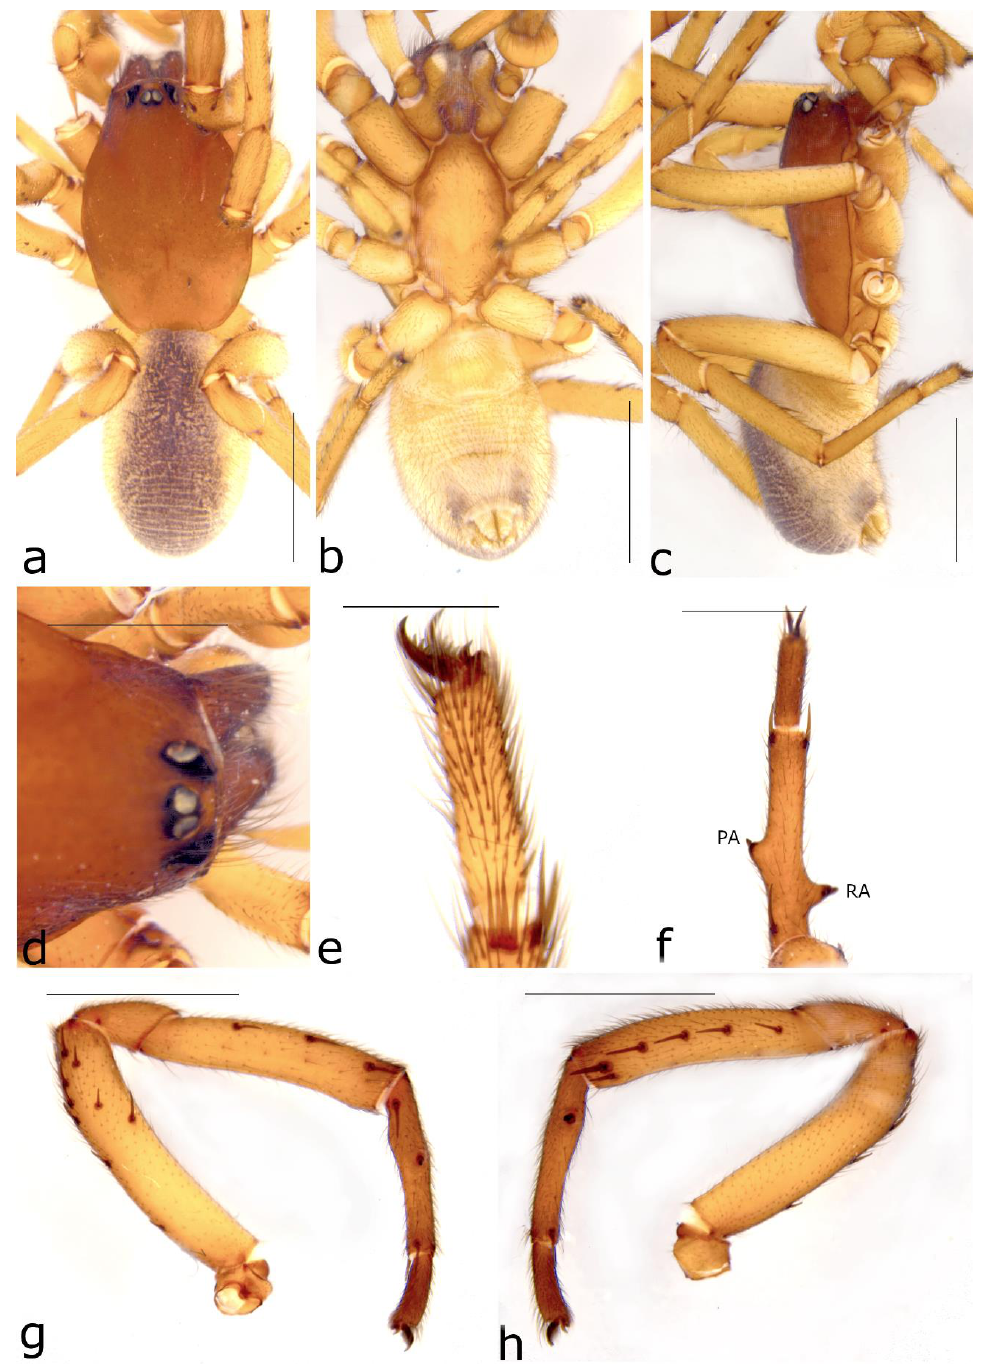
Figure 46. Ariadna propria sp. nov. ♂ holotype (SAMA NN30560) from Melrose (SA): ( a ) habitus, dorsal view; ( b ) same, ventral view; ( c ) same, lateral view; ( d ) eyes, dorsal view; ( e ) left metatarsus IV, preening comb, retrolateral view; ( f ) left leg I, ventral view; ( g ) same, prolateral view; ( h ) same, retrolateral view. Scale bars ( a – d ) = 1 mm, ( e ) = 0.5 mm, ( f ) = 1 mm and ( g , h ) = 2 mm.